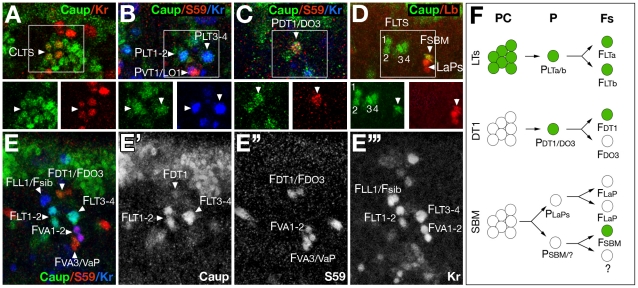
Onset of Caup expression in muscles in relation to other muscle identity genes.All images show a detail of an embryonic wild-type abdominal hemisegment stained with antibodies against Caup (green) and different muscle identity proteins. Images show a ventral view of the embryo, with the exception of B and C that correspond to lateral views. (A–C) Stage 11 embryos. (A) caup and Kr (red) are co-expressed in a lateral transverse promuscular cluster (CLTS). (B–C) caup is co-expressed with Kr (blue) in progenitors of LT muscles (PLT1/LT2 and PLT3/LT4, B) and with slou/S59 (red) in DT1/DO3 progenitor (PDT1/DO3, C). (D) Late stage 12 embryo co-expressing caup and lb in the SBM founder (FSBM). (E) Stage 12 embryo showing co-expression of caup with slou/S59 (red) in DT1 founder (FDT1) and with Kr (blue) in LTs founders (FLT1–4). The position of LL1, LL1sib and VA1–3 founders (FLL1, FLL1sib, FVA1–3) and the ventral adult muscle precursor are also indicated. (F) Schematic representation of ara/caup expression in the LTs, DT1 and SBM lineages (SBM lineage as revised in [17]). LaPs, lateral adult muscle precursors; PC, promuscular cluster; P, muscle progenitor; Fs, founder myoblasts.